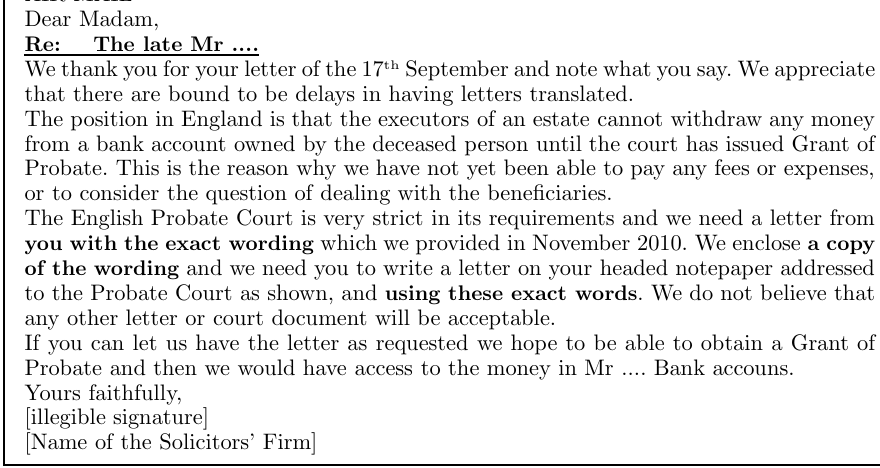
Key words or phrases (in bold) were emphasized by the author of this